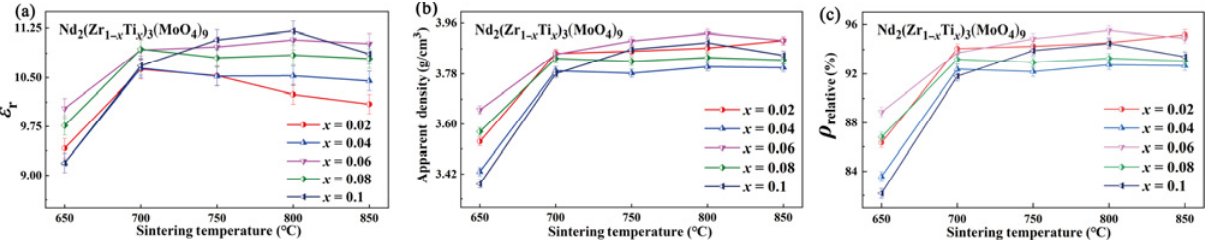
Fig. 6 (a) ε r , (b) apparent density, and (c) ρ relative of NZ 1 − x T x M ( x = 0.02–0.10) ceramics sintered at 650–850 .